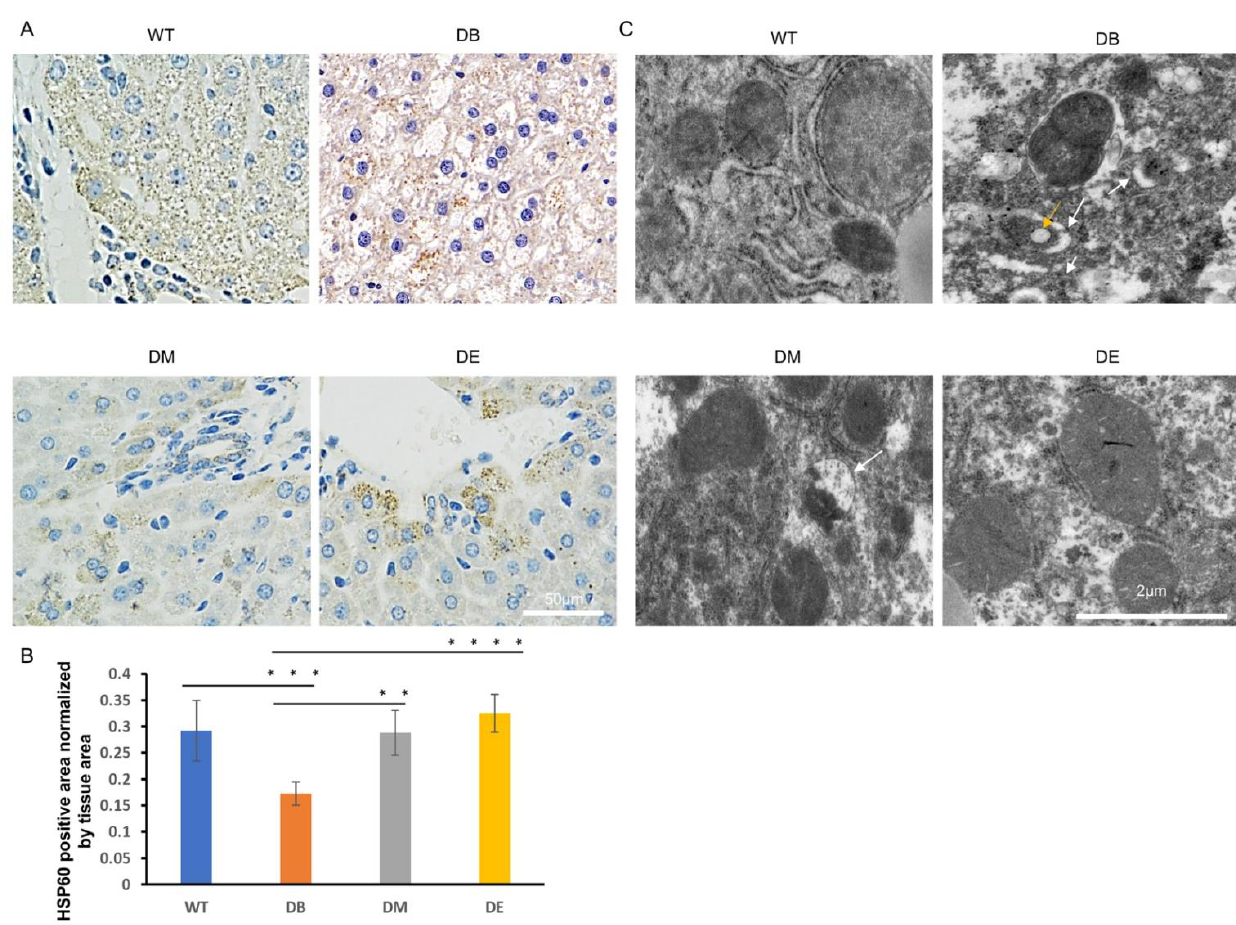
Figure 4. Night exercise is better than morning exercise in ameliorating abnormal mitochondrial networks and morphology caused by diabetes. ( A ) HSP60 staining images of livers from WT, DB, DM, and DE mice ( n = 3). ( B ) Statistical evaluation of HSP60 staining of ( A ), ** p < 0.01, *** p < 0.001 and **** p < 0.0001. ( C ) Electron microscopy images of livers from WT, DB, DM, and DE mice ( n = 3). The yellow arrow indicates the mitochondrial lipid content. The white arrows indicate the outer compartment swollen mitochondria.